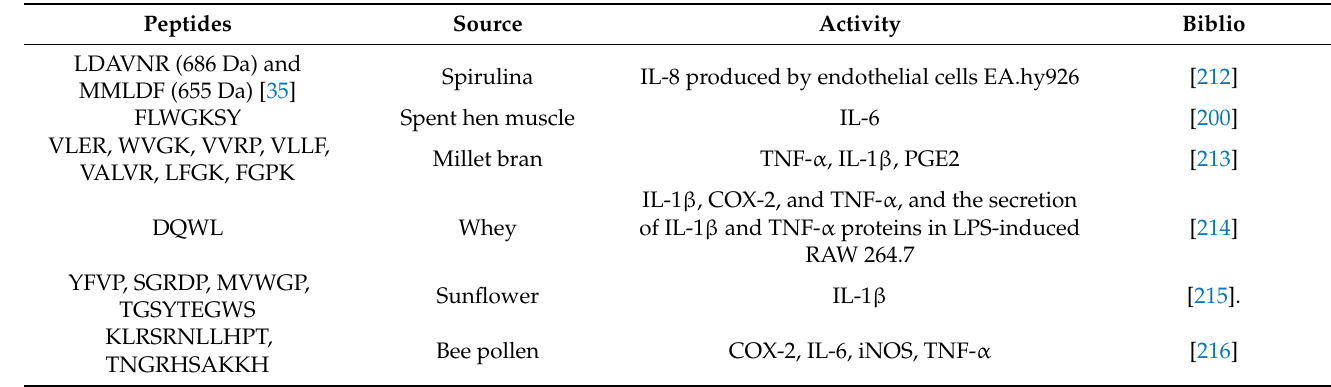
Table 4. Summary of recent studies on anti-inflammatory